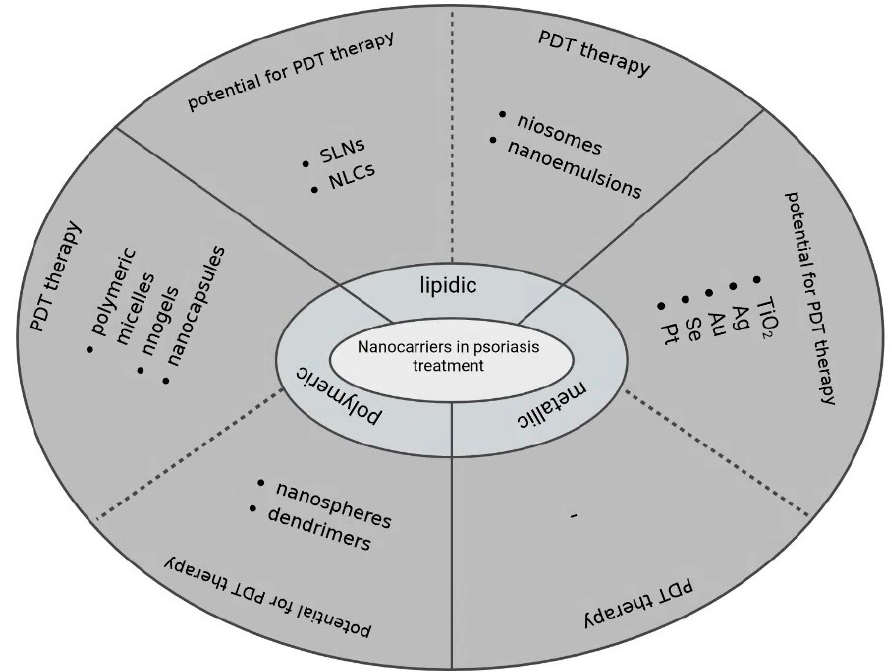
Figure 2. Diagram showing the use of analyzed nanocarriers in psoriasis treatment. Nanocarriers were classified by various studies reporting their use in PDT-based psoriasis treatment and studies proving their great potential in the treatment of other skin diseases.